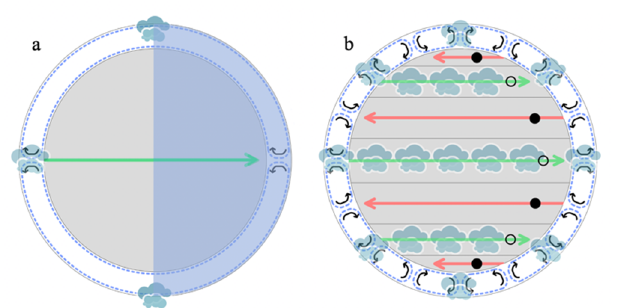
Figure 5. Qualitative illustration of the atmospheric circulation for and preferential location of cloud formation on slowly rotating and rapidly rotating sub Neptunes (not to scale). ( a ) A tidally- locked temperate sub Neptune will be slowly rotating and is expected to have a single planet-wide circulation cell with a symmetric day–night circulation moving away from the substellar point (left side of the figure at the base of the green arrow) and returning at a lower level after downwelling at the night side. Clouds may form at the dayside (left side of the figure) and/or terminator, depending on a complex interplay of a variety of factors and based on simulations [51]. The blue-shaded region indicates the permanent planet night side. Adapted from [51]’s description of K2-18 b. ( b ) A rapidly rotating planet is expected to have multiple latitudinal cells, with alternating wind direction (indicated by arrows). The latitudinal cells may also alternate between upwelling regions (indicated by open circles with dots) with clouds and downwelling regions (indicated by filled circles) that are cloud free, though this picture will be complicated by other dynamics. A key takeaway is both the slowly and rapidly rotating planets likely have a return atmosphere flow at a low atmosphere altitude; if the temperature is cool enough life can survive indefinitely.